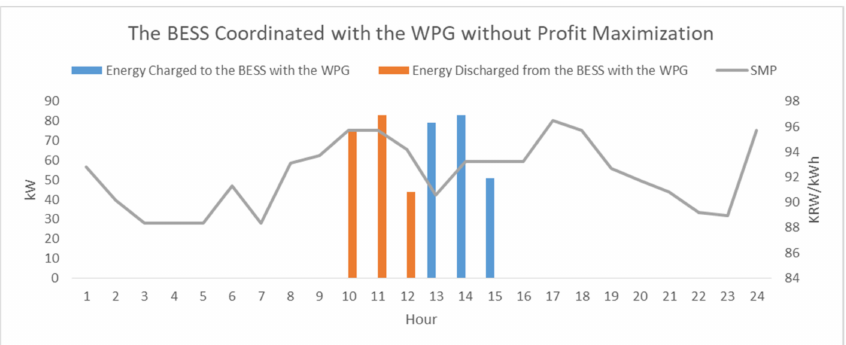
Figure 3. Intraday operation of the BESS charging and discharging without profit maximization.